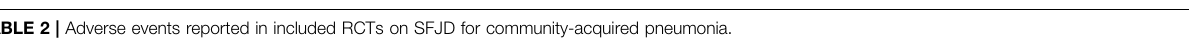
TABLE 2 | Adverse events reported in included RCTs on SFJD for community-acquired